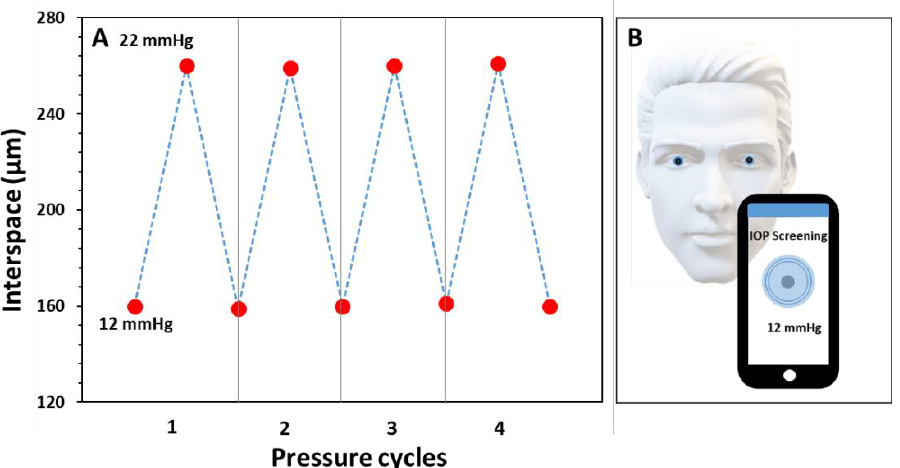
Figure 6. ( A ) The contact lens with a ring-couple interspace of 1.5 mm exposed to low and high pressure for four cycles; ( B ) A schematic representation of the developed sensor when read by the smartphone.